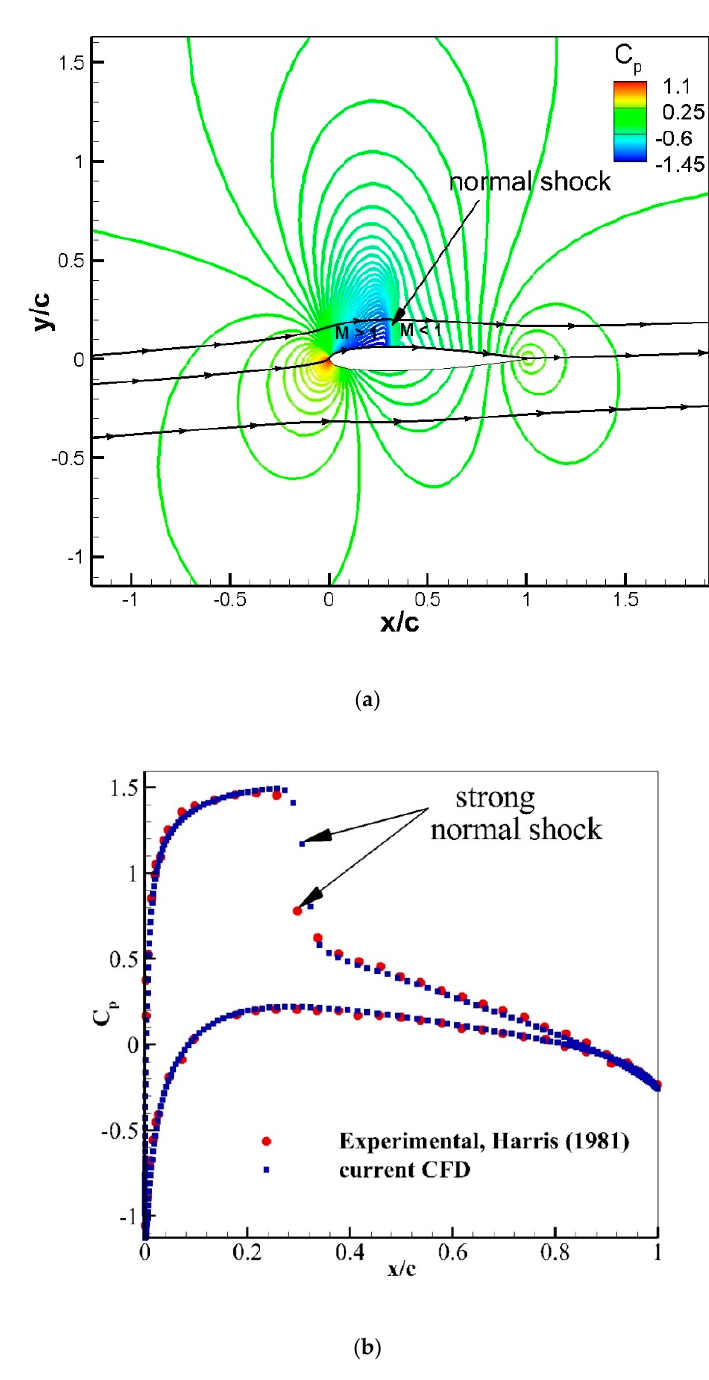
Figure 9. ( a ) Coe ffi cient of pressure contours and ( b ) surface pressure coe ffi cient for the NACA0012 Figure 9. ( a ) Coefficient of pressure contours and ( b ) surface pressure coefficient for the NACA0012 airfoil at Mach = 0.7 and Re ∞ = 9 × 10 6 at an angle of attack = 3.1 ◦ airfoil at Mach = 0.7 and Re ∞ = 9 × 10 6 at an angle of attack = 3.1°.